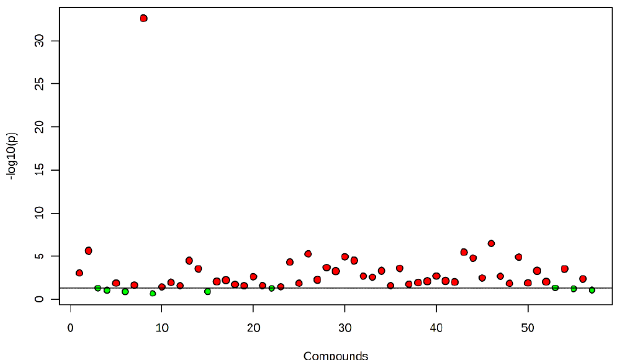
weight. Values represents the means of three replicate, and values within the same row with different superscript letters are significantly different ( p < 0.05).